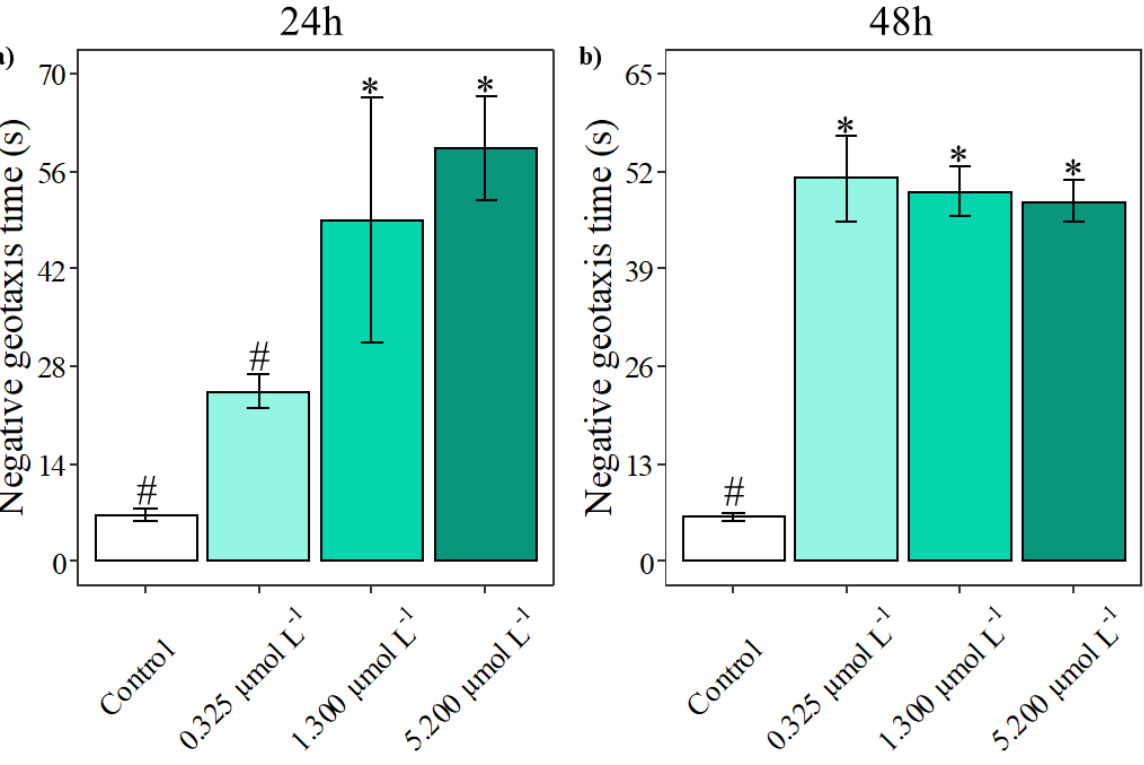
Figure 2. Locomotor behavior of Drosophila melanogaster exposed to three concentrations of 2-Phenylethynyl- Butyltellurium (PEBT) verified through the negative geotaxis test, in 24h (a) and 48h (b). * Significant difference compared with #. # Significant difference compared with